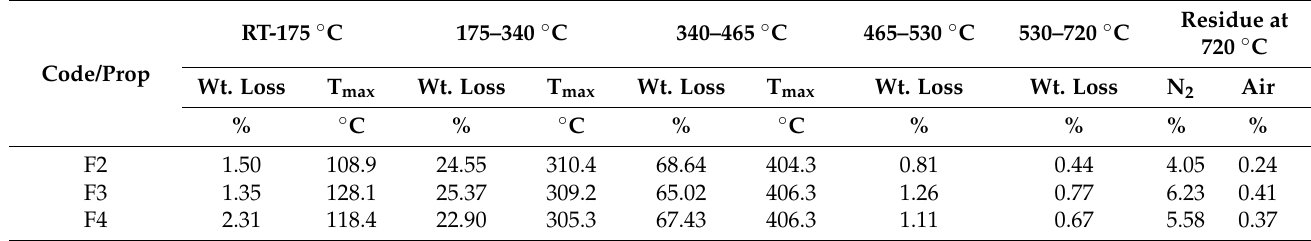
Table 9. Thermal degradation of primary compounds (TGA measurements).